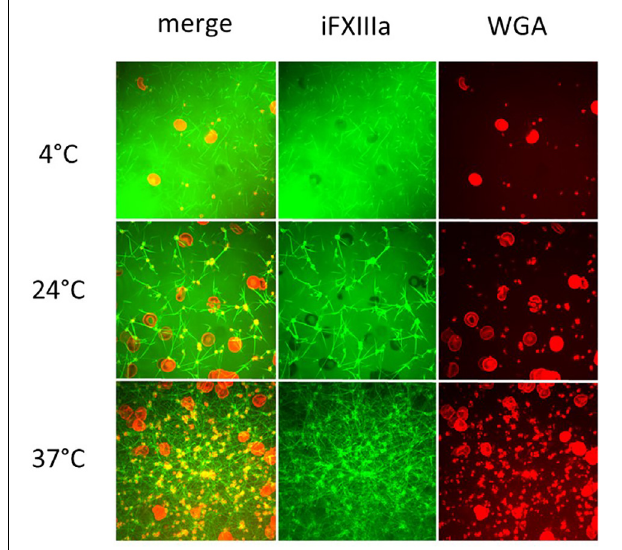
FIGURE 4 | Influence of temperature on coagulation and platelet function visualized with Real Time Live Confocal Imaging. Representative pictures of one healthy volunteer were chosen to visualize the fibrin network (green, iFXIIIa), platelet aggregates (yellow due to WGA and iFXIIIa overlay), and erythrocytes (red, WGA) at 4 ◦ C (first row), 24 ◦ C (middle row), and 37 ◦ C (bottom row). Merged channels (left column) as well as iFXIIIa channel (middle column) and WGA channel (right column) are shown. As expected, fibrin network density increases with temperature as well as platelet activity. Objective: 63 × oil